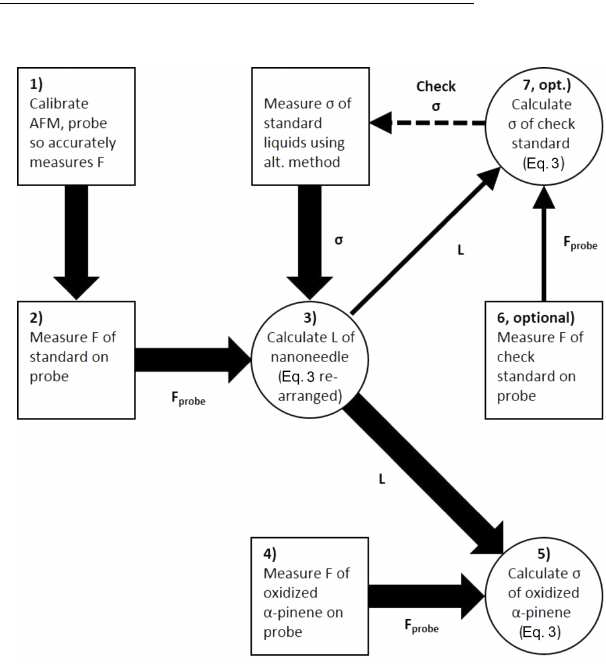
Figure 4. Procedure used to determine the surface tension of ox- idized α -pinene particles using the AFM. The cantilever’s spring constant was determined (step 1), which allowed for the AFM to obtain force curves. Force curves of a liquid standard were obtained (step 2), and the nanoneedle’s wetted perimeter was calculated with Eq. (3) given the standard’s known surface tension (step 3). Force curves of the oxidized α -pinene sample were obtained (step 4), and its surface tension was calculated with Eq. (3) given the nanonee- dle’s wetted perimeter (step 5). For initial tests, a check standard was used to verify the validity of the wetted perimeter and sample surface tension calculations (optional steps